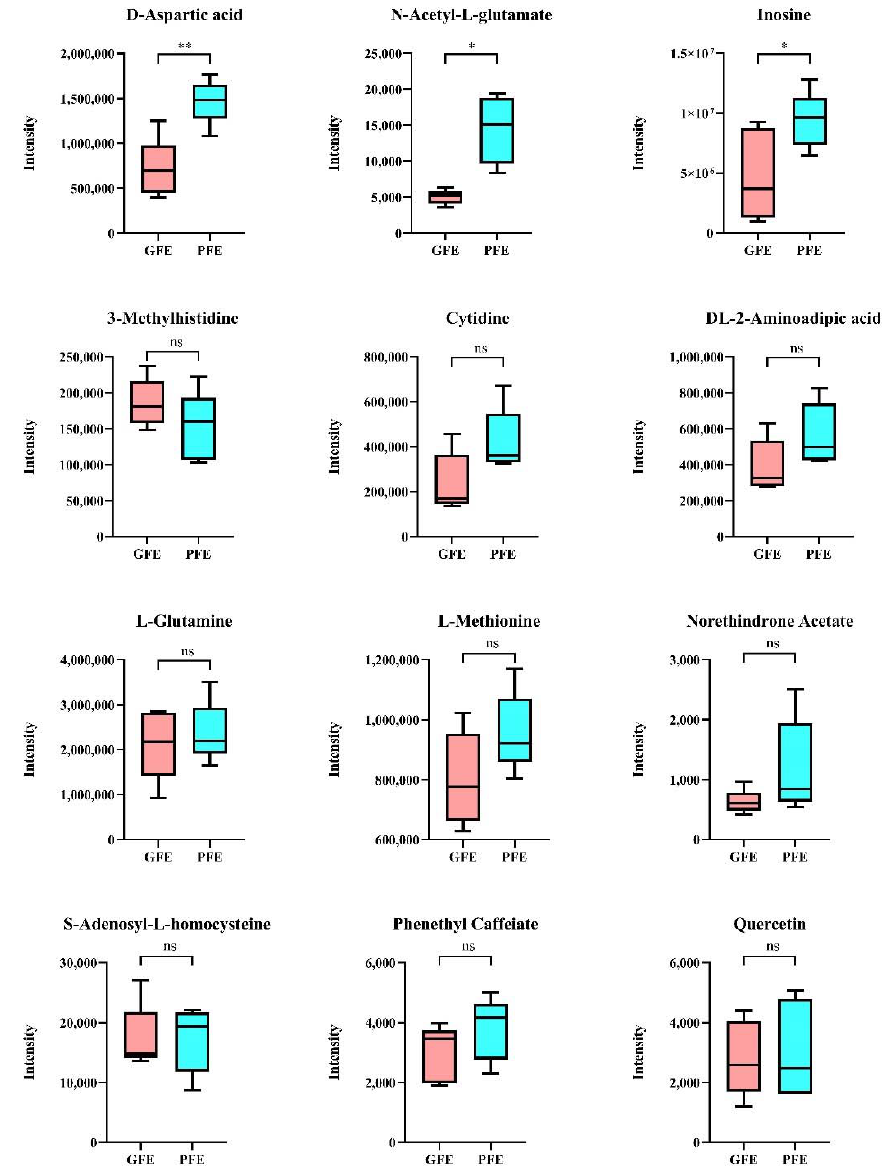
Figure 6. Content of metabolites confirmed by targeted metabolic analysis. Asterisk denotes signifi- cant differences between GFE within PFE. * p < 0.05; ** p <